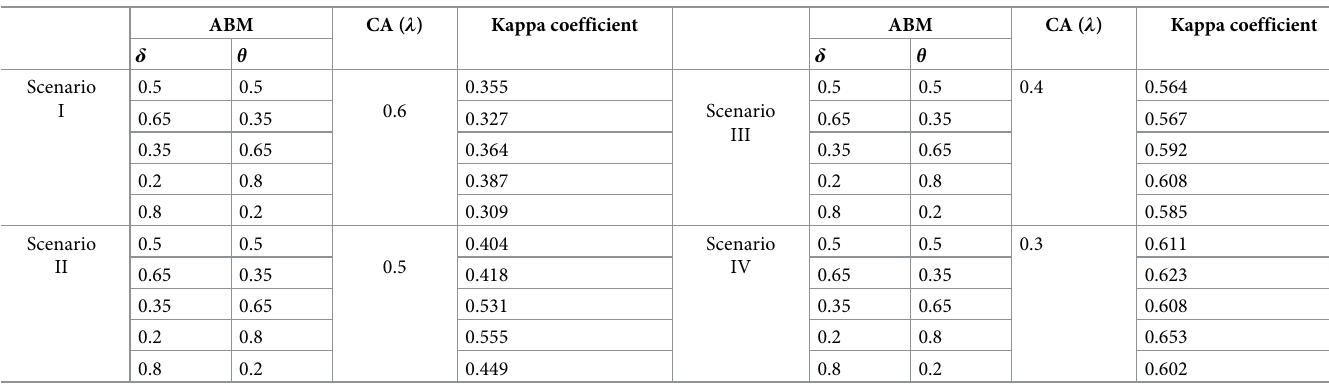
Table 3. Multi-scenario simulation in CA-ABM.